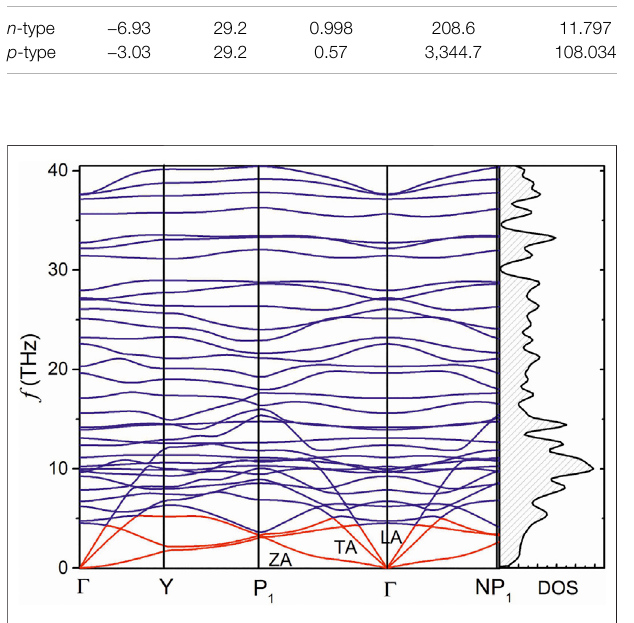
FIGURE3| Thephonondispersion and density ofstatesofthe β s 1 boron